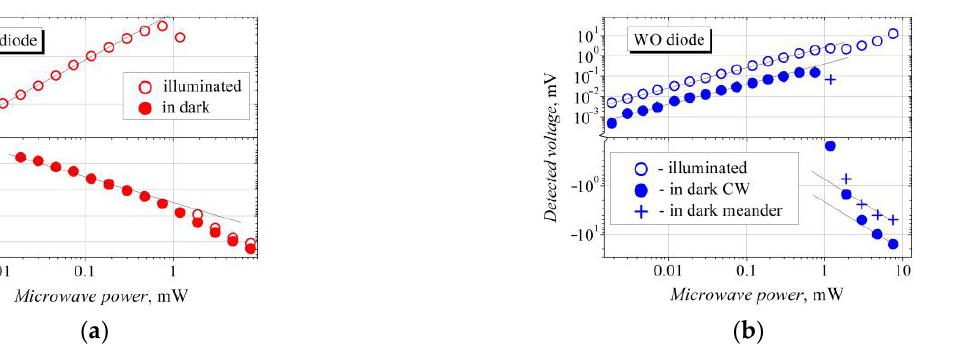
Figure 5. Voltage – power characteristics of the bow-tie diodes on the bases of W ( a ) and WO ( b ) semiconductor structures in the dark (solid dots) and under white-light illumination. The illuminance of the lamp was 14,400 lx. The lines are guides of linear dependence.